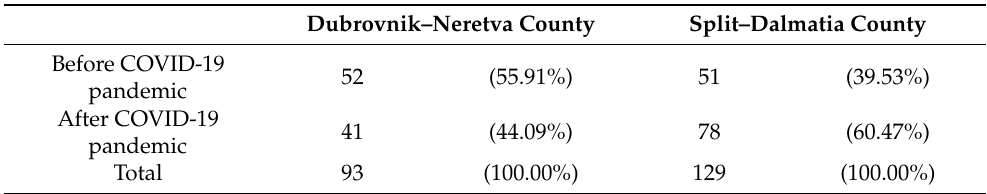
Table 5. Distribution of the number of flights from different counties after and before the COVID-19 pandemic. Data are presented as number (percent), chi-square = 5.83, P = 0.011. Dubrovnik–Neretva County Split–Dalmatia